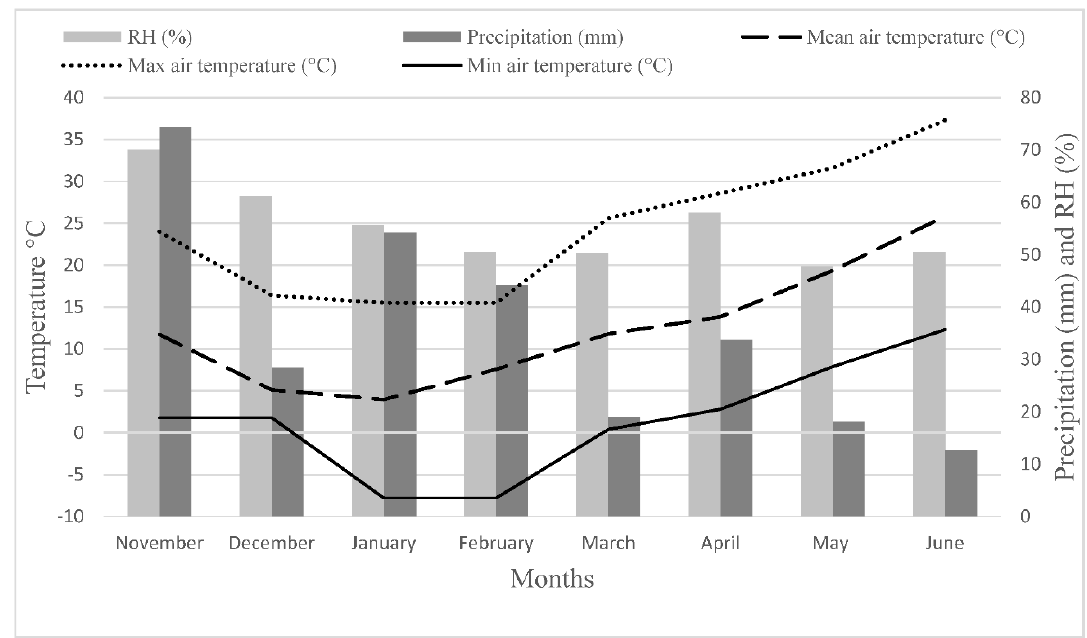
Figure 1. Climate conditions (mean, maximum and minimum temperature, relative humidity (RH) and precipitation) during the experimental period (November 2018–June 2019).